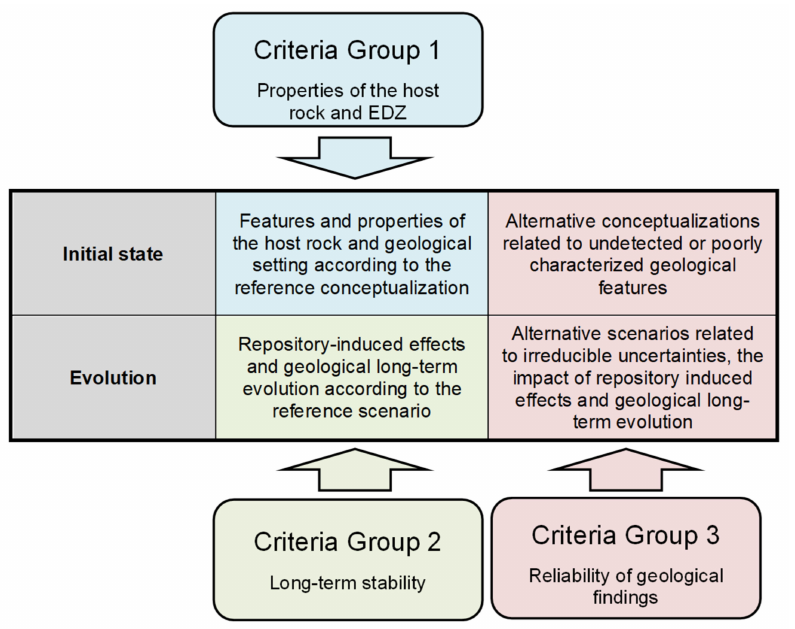
Figure 1. Criteria for site selection to be assessed from the viewpoint of safety and technical feasibility according to [5].